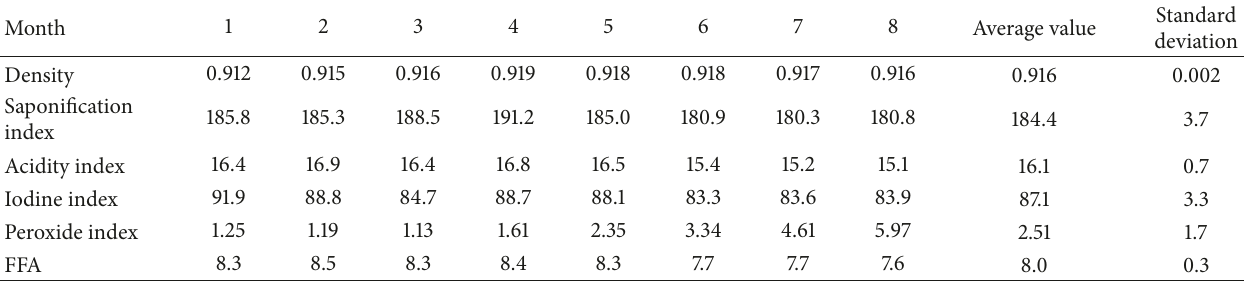
Table 3: Evolution of the physicochemical parameters of raw oil under storage